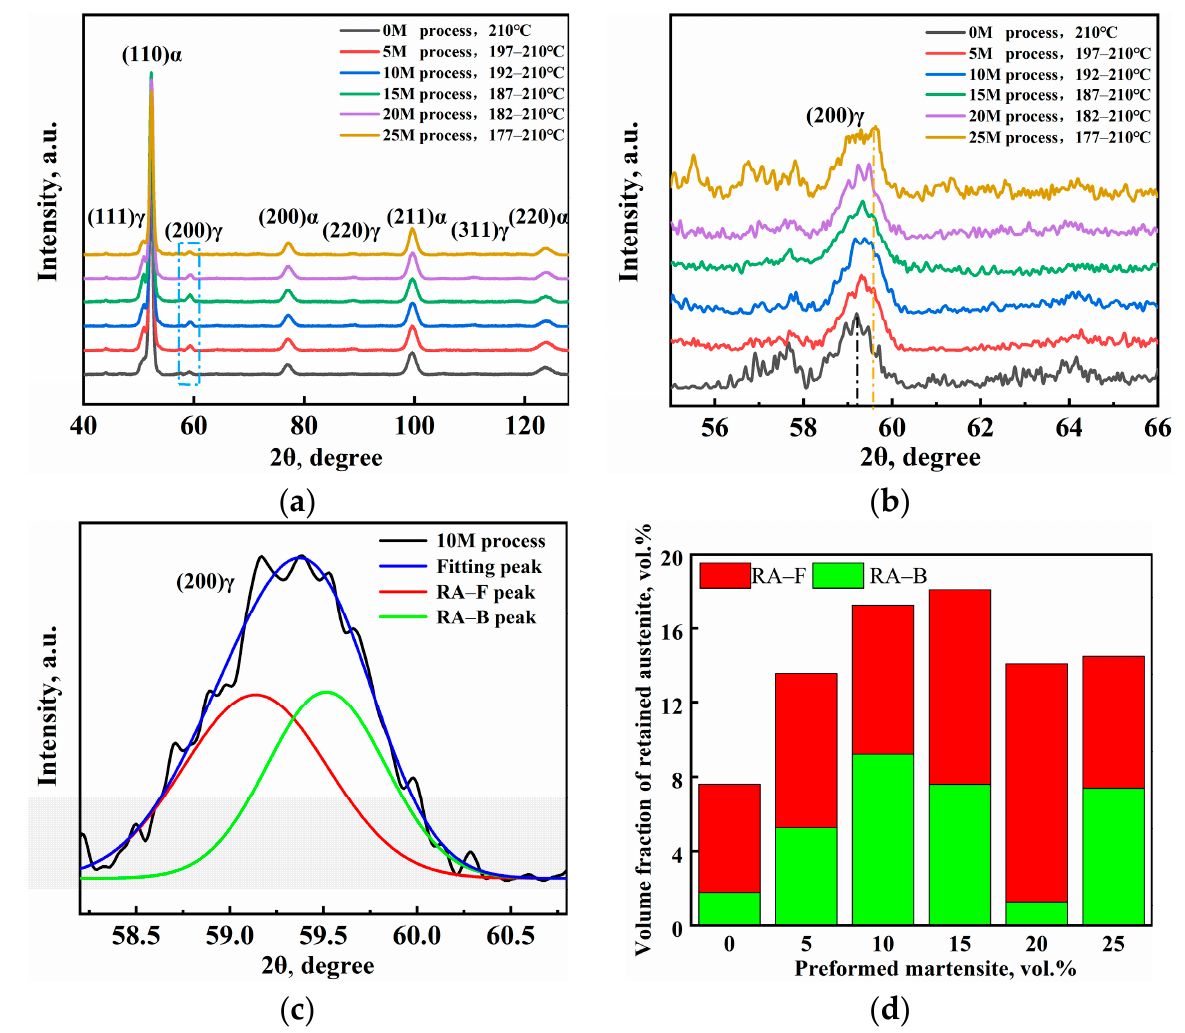
Figure 5. ( a ) XRD patterns, ( b ) partial patterns of (200) γ peak, ( c ) Gaussian fitting curves of (200) γ peak of 10 M specimen, ( d ) volume fractions of blocky and filmy retained austenite.